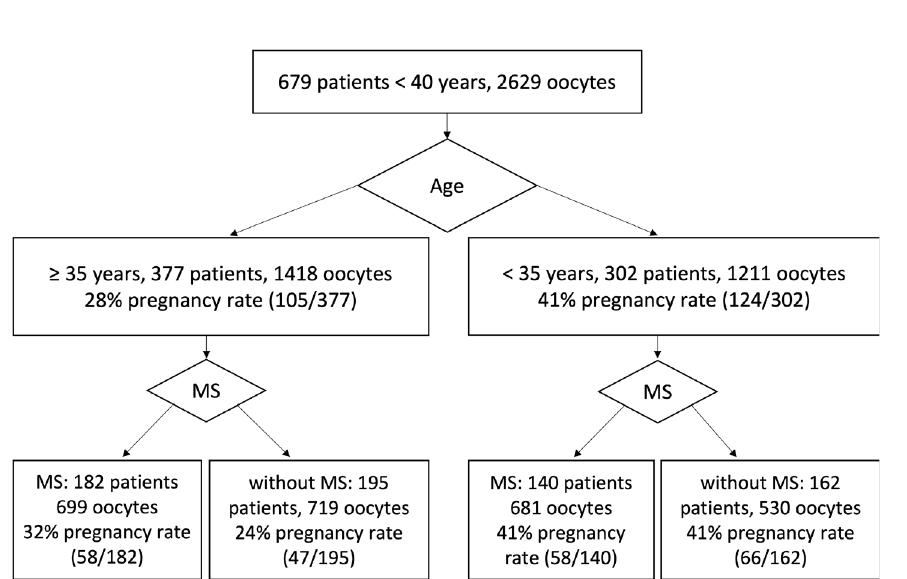
Figure 1. A total of 679 patients with planned ICSI fertilization were divided into two age dependent groups: 1. 377 patients older than 35 and younger than 40; 2. 302 patients younger than 35. For each age dependent group part of the patients had the time of ICSI determined on the basis of the relative position of PB and MS and the MS visibility. We compared the probability of clinical pregnancy for patients with the time of ICSI determined on the basis of the relative position of PB and MS and the MS visibility with the probability of clinical pregnancy for patients without MS evaluation.